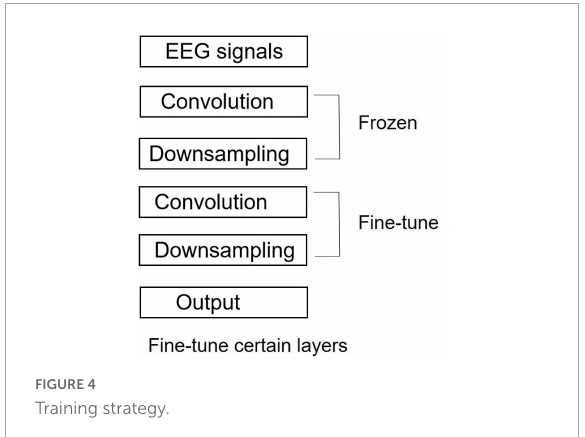
FIGURE4 Training